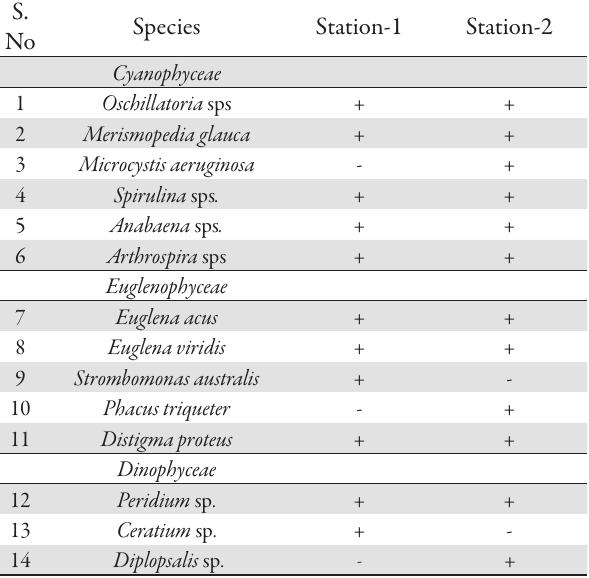
Tab. 2. Phytoplankton of Bacillariophyceae S.